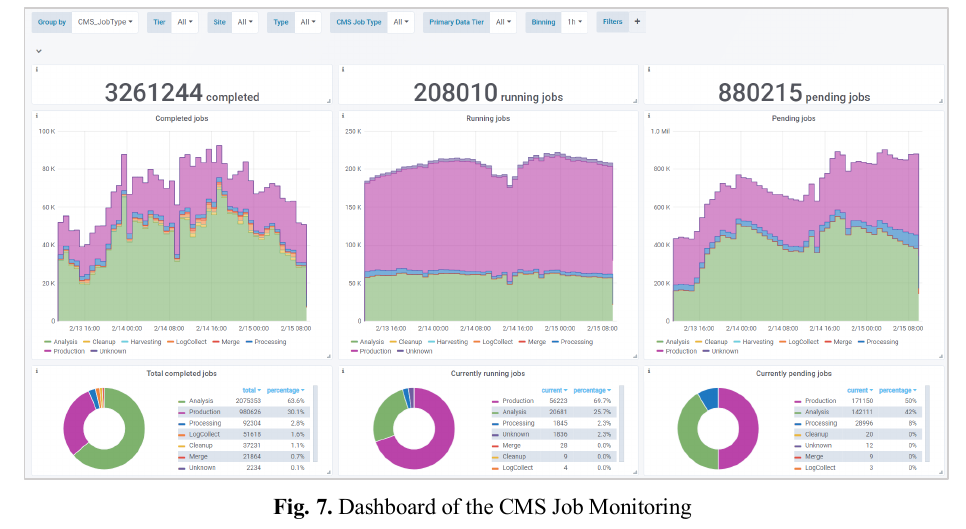
Fig. 7. Dashboard of the CMS Job Monitoring